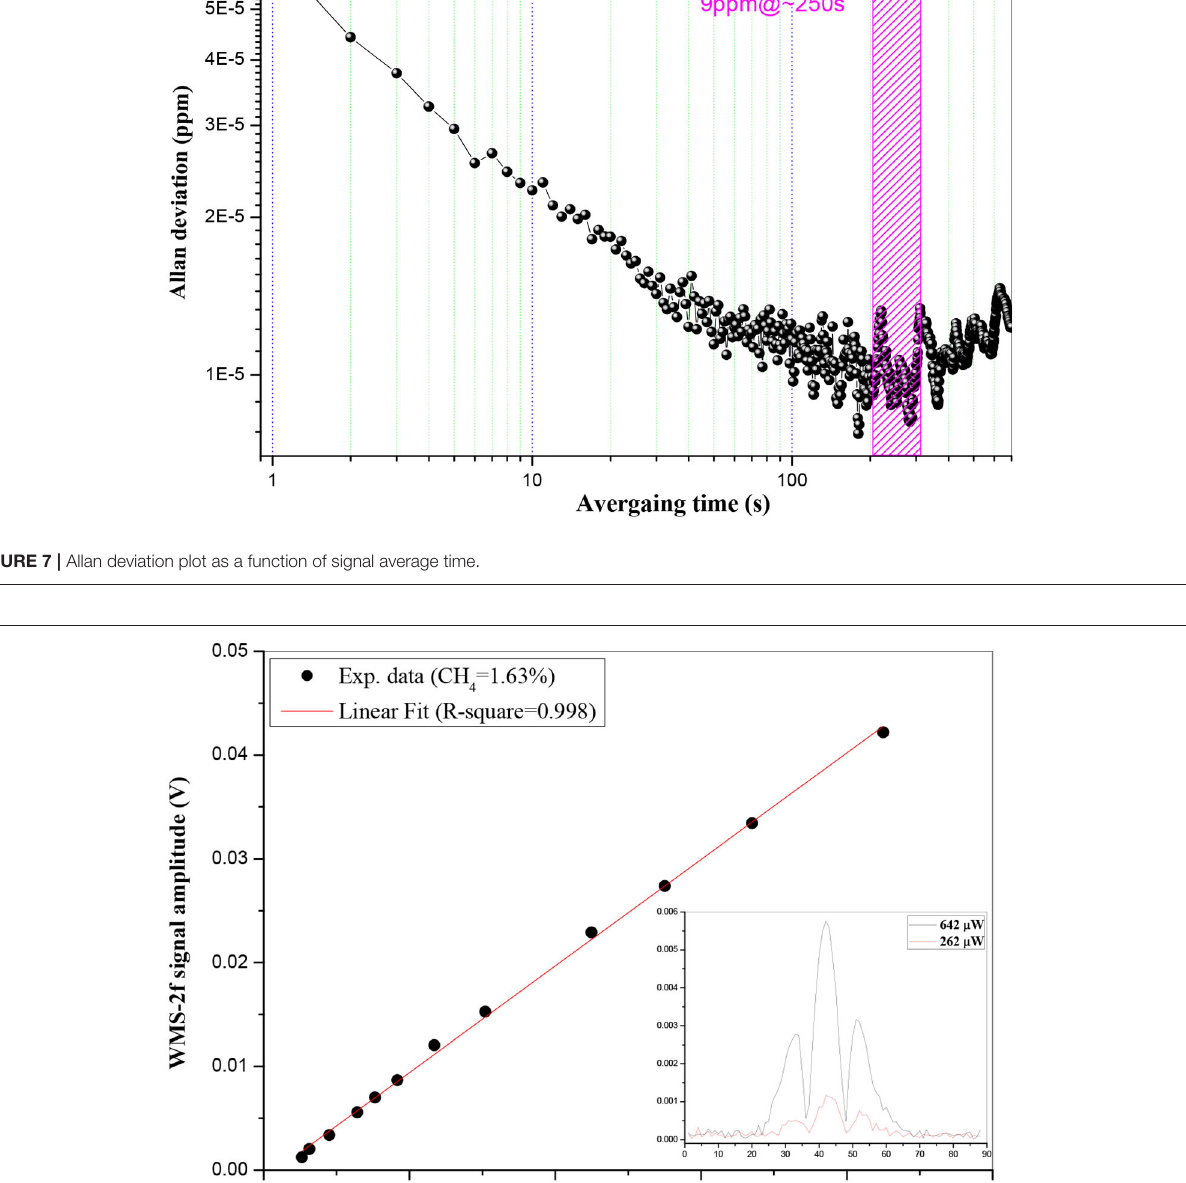
Frontiers in Physics |